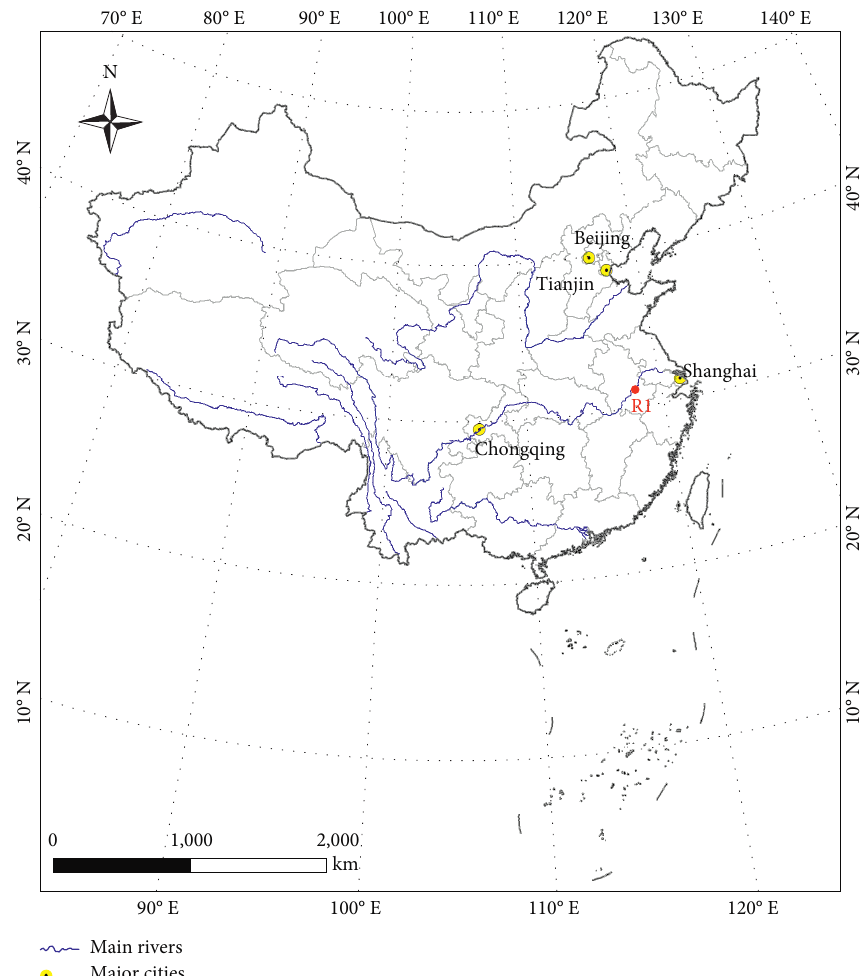
Figure 1: Location map showing Wuhu City, Anhui Province, China.